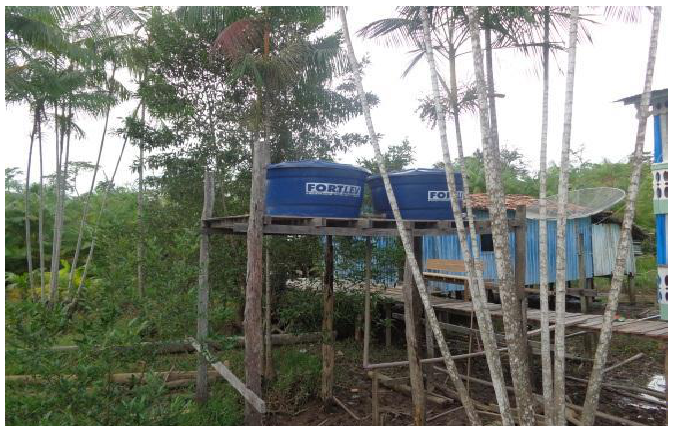
Figura 2 - Água do rio acondicionada em caixas de PVC. Fonte: IATAM (2015).